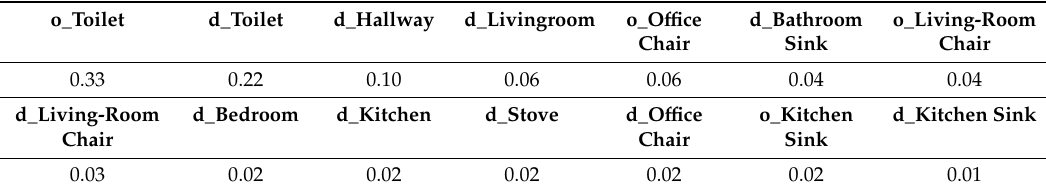
Table 9. Decision tree-based importance for each feature in distinguishing cognitively healthy and cognitive decline subjects based on behavior